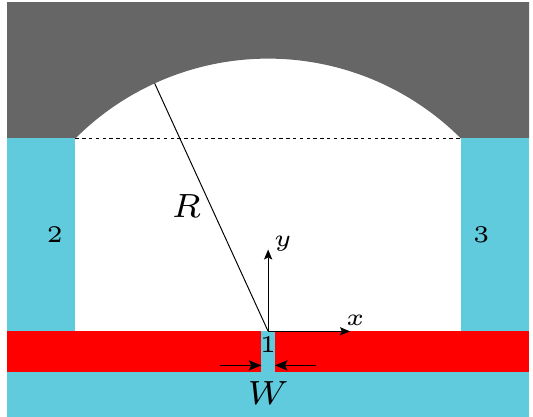
Figure 1: Sketch of the system geometry considered. Red areas represent high po- tential regions that define the QPC of width W . The gray area indicates the mirror potential with a circular edge of radius R that is intended to reflect electrons back into the QPC, and which is present in most of our calculations. In our transport cal- culations, we consider the conductance between the electrodes 1, 2, and 3 shown in blue, and in particular from electrode 1 to 2 or 1 to 3. The dashed line indicates the possible tip positions that are assumed in our simulations of